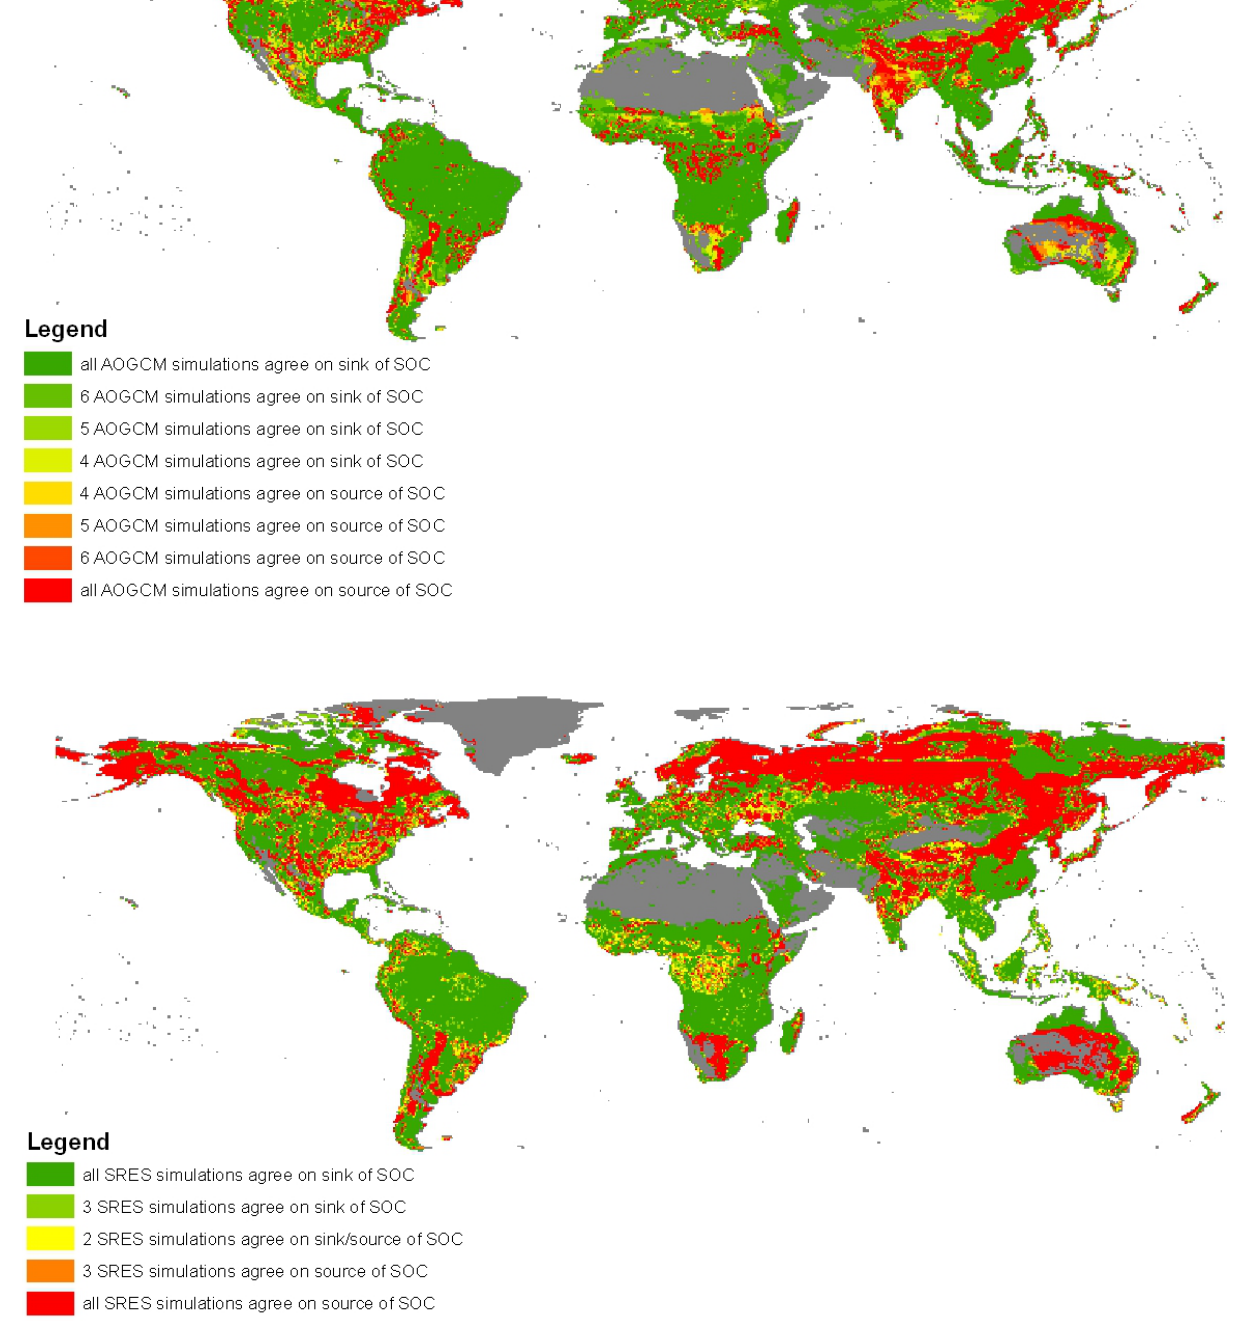
Fig. 12. Spatial distribution of areas where (a) the GCM simulation produces agreement on SOC becoming a source or a sink in 2100 when implemented in RothC, (b) SRES simulations with HadCM3 produce agreement on soils becoming a C source or a sink in 2100 when implemented in